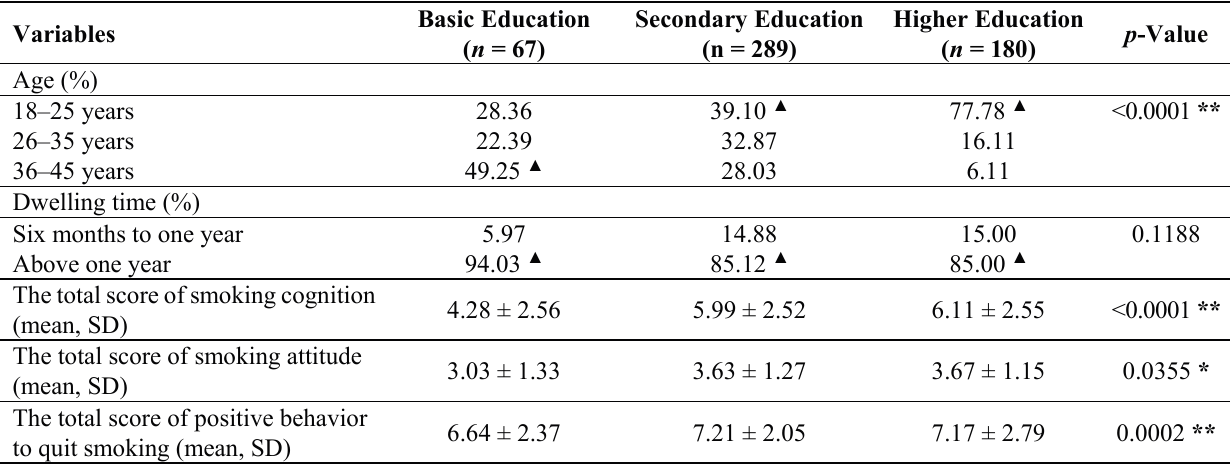
Table 1. Characteristics of the study participants, Chongqing, China, 2011.